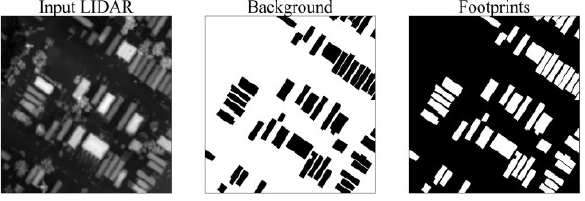
Figure 6. Example of one training data sample. The geographical extent of the input and output raster corresponds to the extent of each grid cells introduced in Section 4.